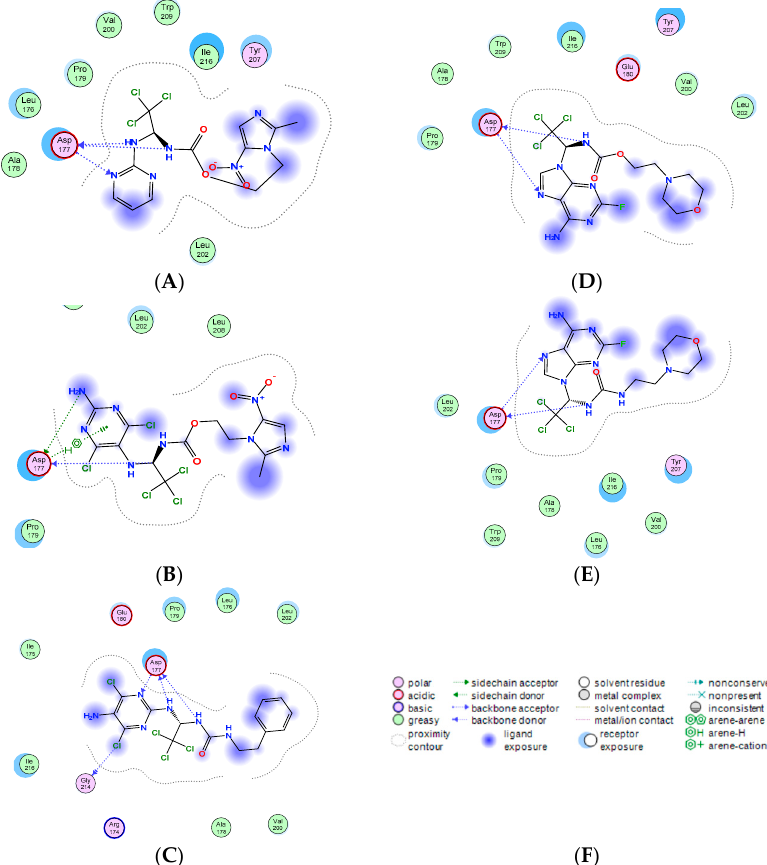
Figure 3. Predicted ligand interactions for ( A ) Apcin, ( B ) compound 7d, ( C ) compound 20, ( D ) com- pound 9f, ( E ) compound 27 bound to the Cdc20 crystal structure (PDB ID: 4n14). ( F ) This figure is an annotated illustration of the above figures. The binding ability of compounds B, C, D, and E with Cdc20 protein was evaluated by affinity values, and the results are as follows: S = − 7.1530 ( B ), S = − 6.6634 ( C ), S = − 6.5298 ( D ), S = − 6.7957 ( E ).